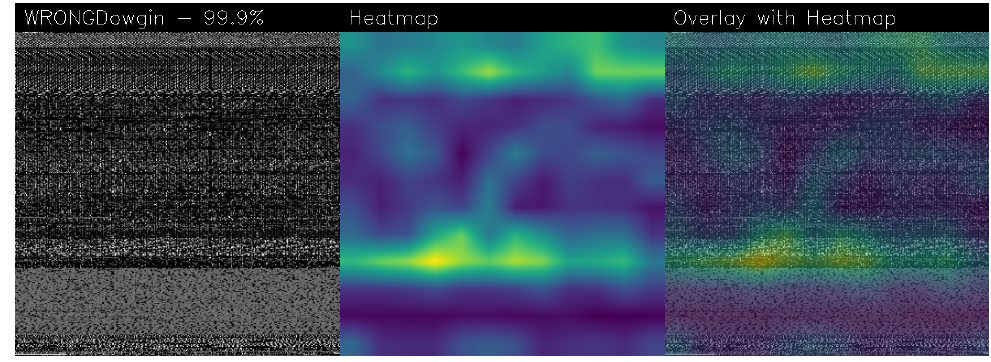
Figure 9. The wrong classification of the sample Airpush (da46241dde7209feb52ff1b37e8f5080) misclassified as belonging to the Dowgi fam-